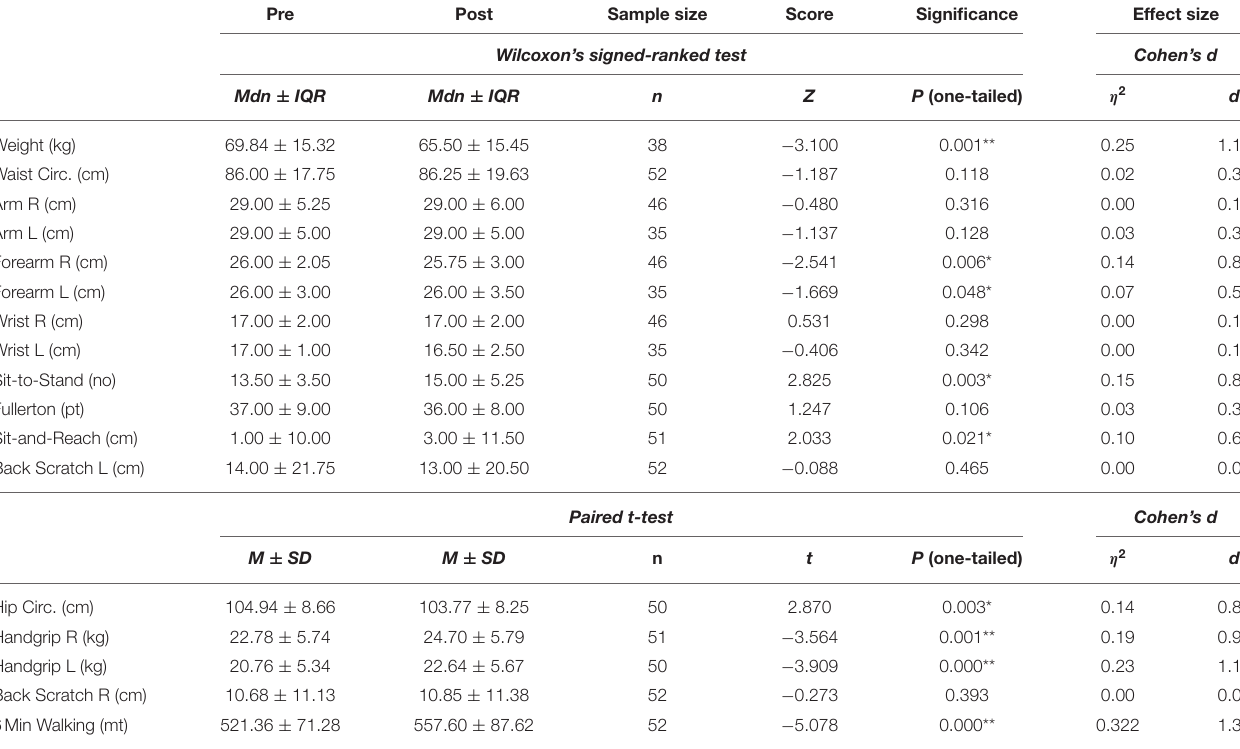
TABLE 2 | Anthropometric and Fitness Measures Pre–Post Intervention Comparisons. Pre Post Sample size Score Significance Effect size